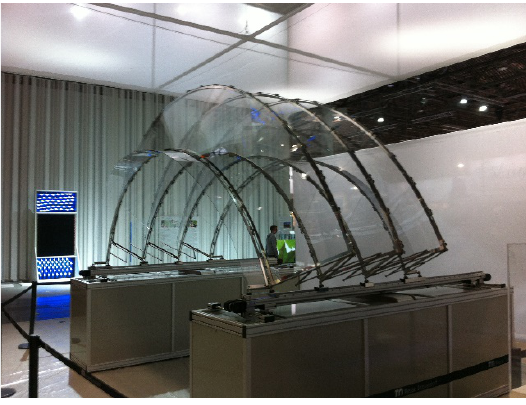
Fig. 1 Skin folding canopy at Glasstec 2014 in